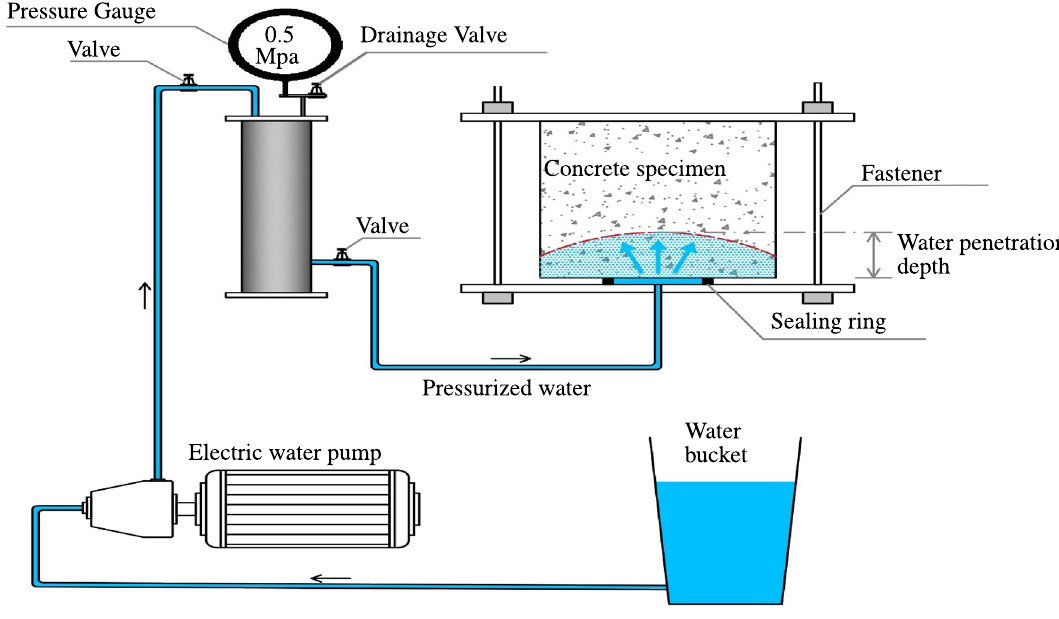
Figure 6. Schematic of penetration testing of the concrete